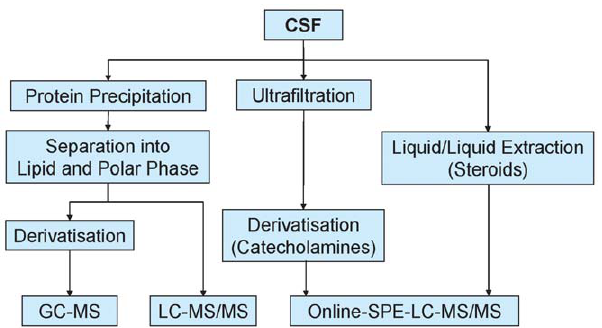
Figure 1.The metabolite profiling techniques applied to the analysis of CSF